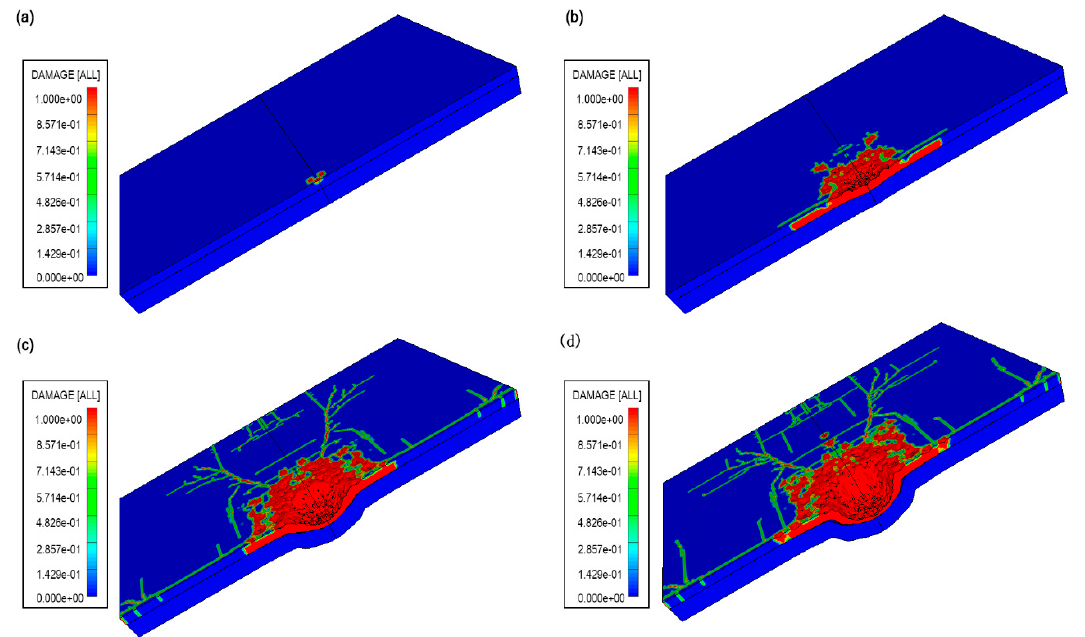
Figure 16. The damage contours of the rear plate in Configuration B-2 at different times after impact (( a ) t = 0 ms; ( b ) t = 0.01 ms; ( c ) t = 0.02 ms; ( d ) t = 0.03 ms).